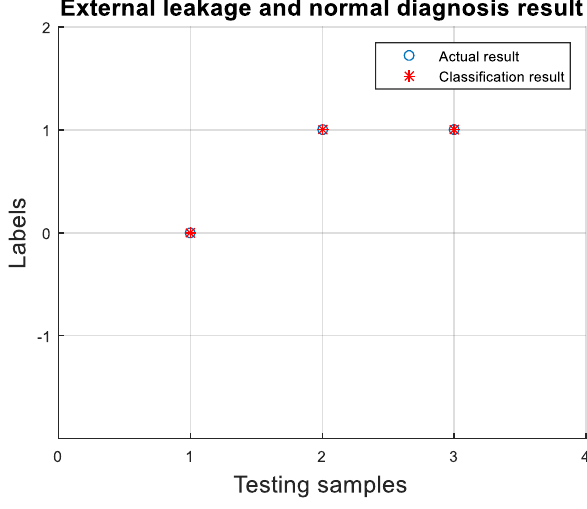
Figure 9. Relay valve external leakage and normal diagnosis result.